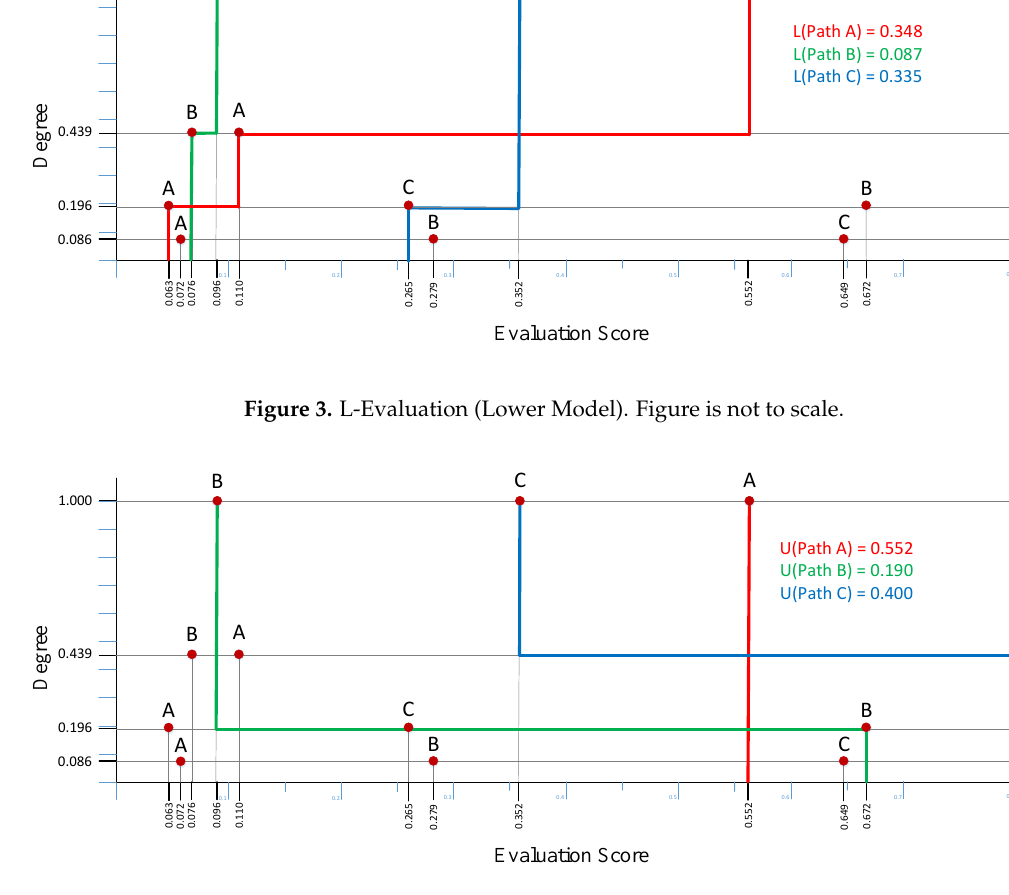
Figure 4. U-Evaluation (Upper Model). Figure is not to